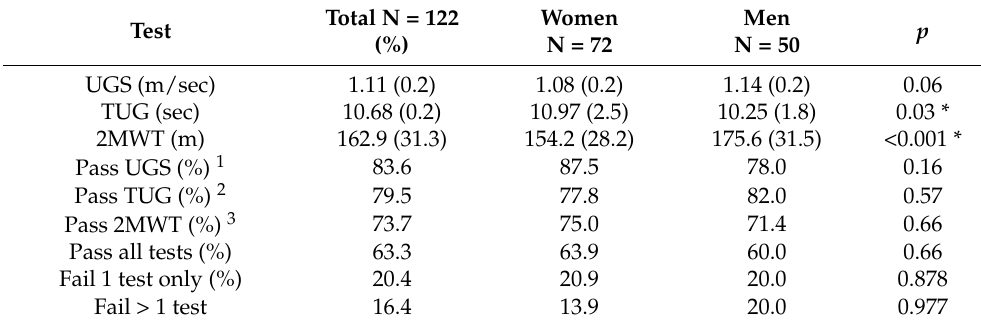
Table 2. Mobility characteristics of the participants in the